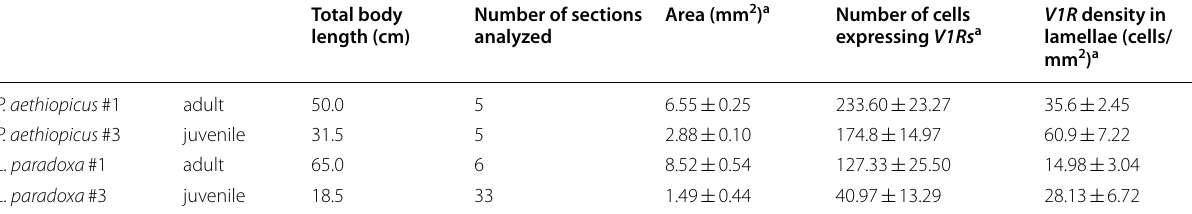
Table 6 Comparison of V1R -expressing cell density in the lamellae between adult and